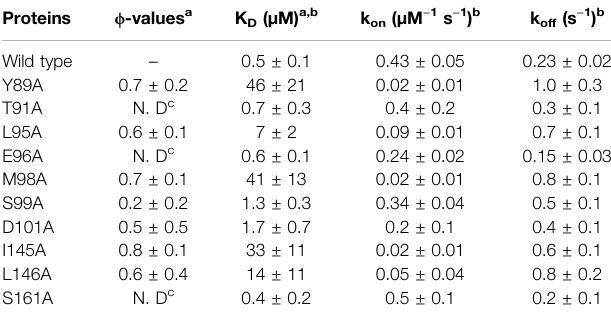
a Uncertainties represent propagated errors. b Allvaluesarerepresentedbyaverage ± standarddeviationof3repeats.Averagevalues were rounded to have the same number of signi fi cant fi gures with standard deviation. c Not Determined due to small ΔΔ G ° .